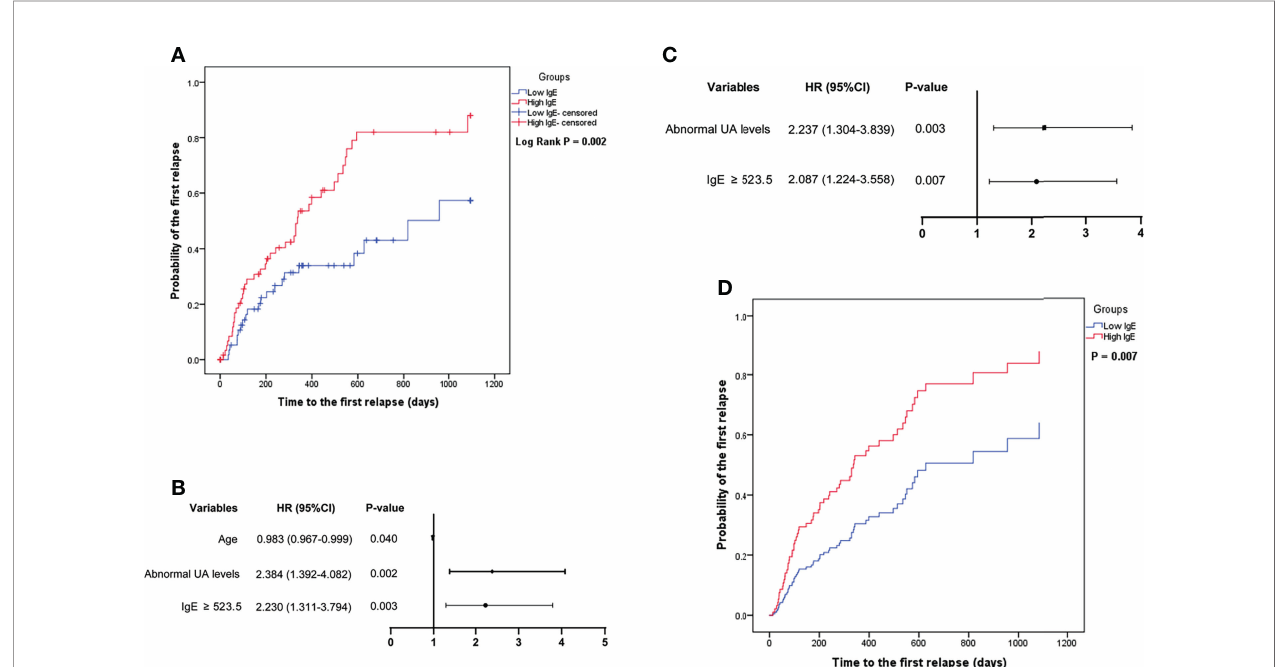
FIGURE 3 | Comparison of the probability of the fi rst relapse of minimal change disease in the low- and high-IgE groups (A) , and the identi fi cation of independent correlation factors for relapse by univariate (B) and multivariate (C) cox regression analysis. (D) Serum IgE levels were independent correlation factors for relapse of minimal change disease. UA , uric